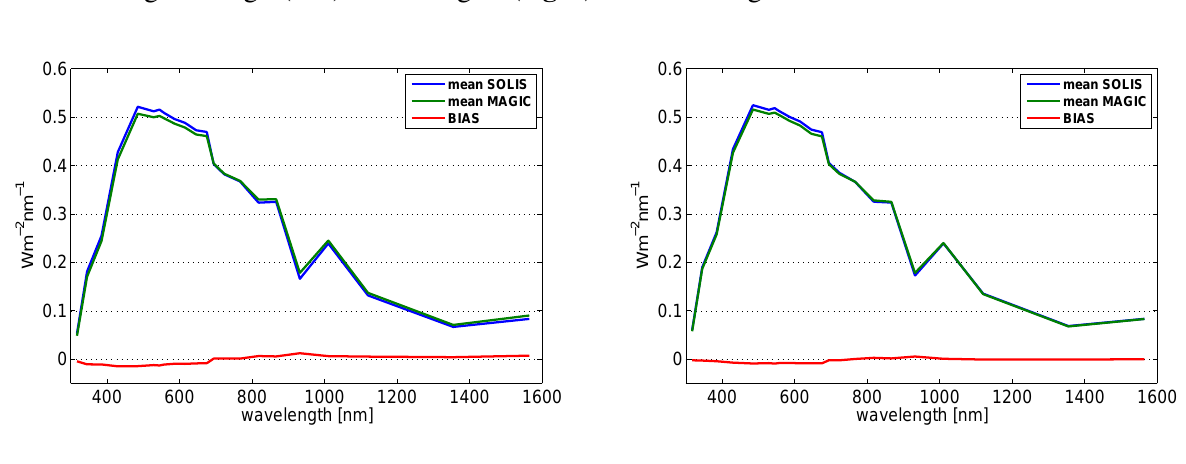
Figure 8. Average spectrum for Kato bands retrieved with SPECMAGIC and with SOLIS for Loughborough ( left ) and Stuttgart ( right ). The bias is given in